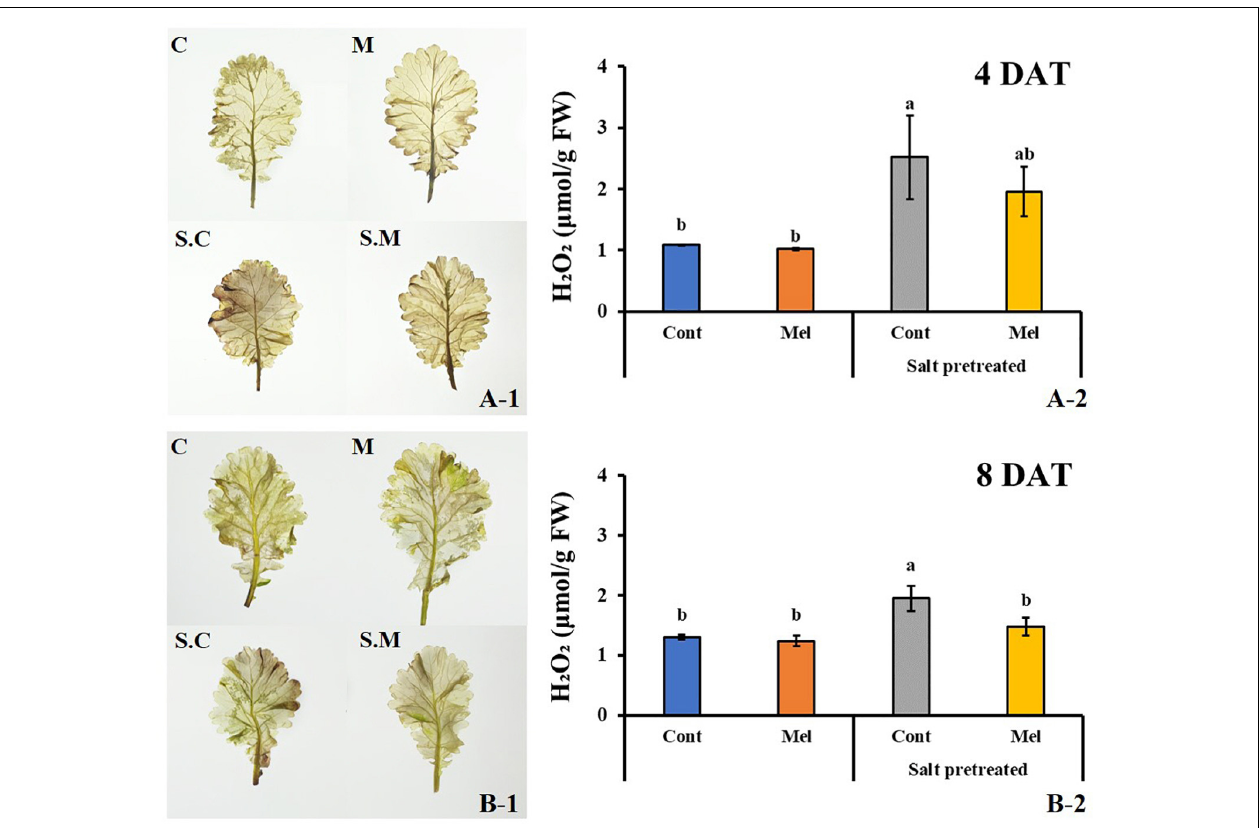
FIGURE 12 | Effect of melatonin with/without salt stress on H 2 O 2 content in green mustard seedlings. DAB staining was used to visualize the accumulation of H 2 O 2 in leaves on day 4 ( 4DAT; A-1 ) and day 8 (8DAT; B-1 ) of treatment. The H 2 O 2 contents were calculated from data for 4 (4DAT; A-2 ) and 8 (8DAT; B-2 )